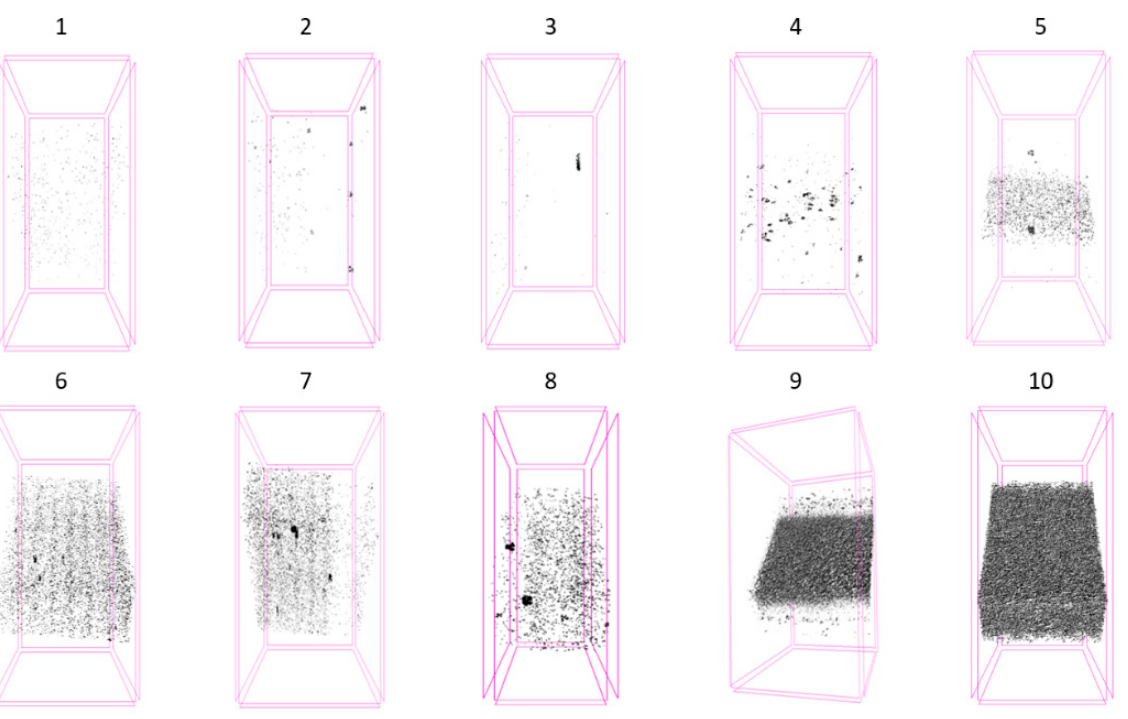
Figure 12. µCT pictures showing the distribution of porosity on samples as a function of the number of recyclings they were subjected to.